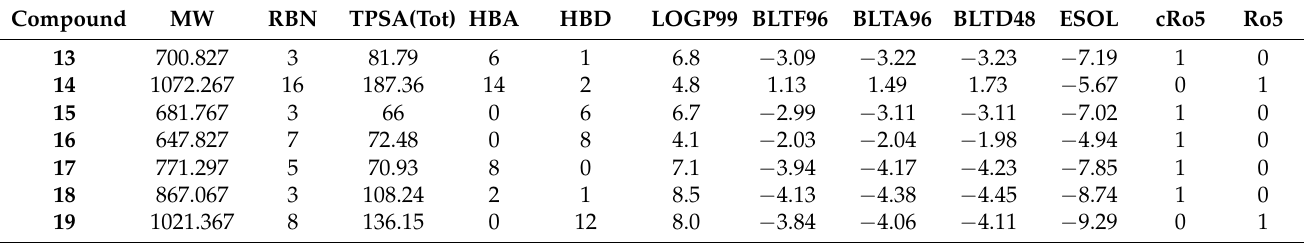
Table 2. Drug-likeness properties of active antimicrobial rhenium complexes 13–19